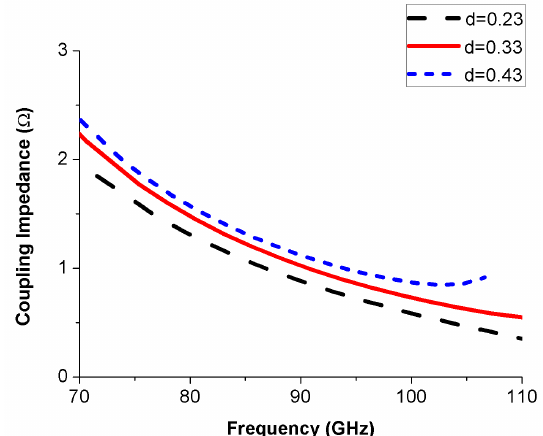
Figure 4. Coupling impedance of the CV-FWG for various values of Ac.